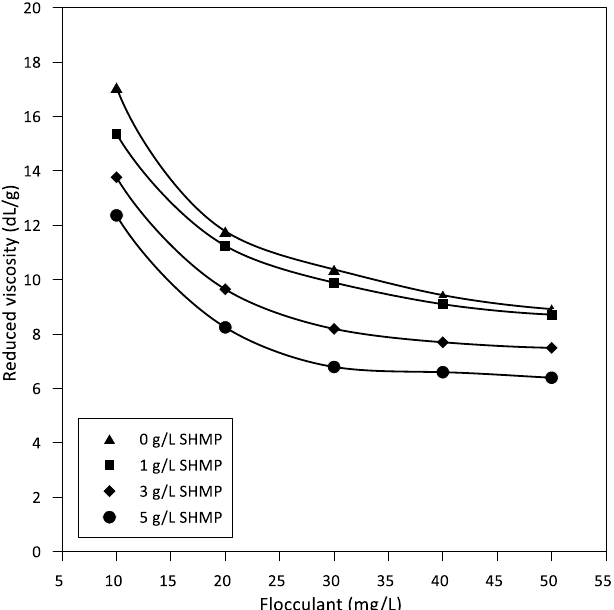
Figure 7. Reduced viscosity of CYFLOC A-150 HW flocculant as a function of flocculant dose at different SHMP concentration.